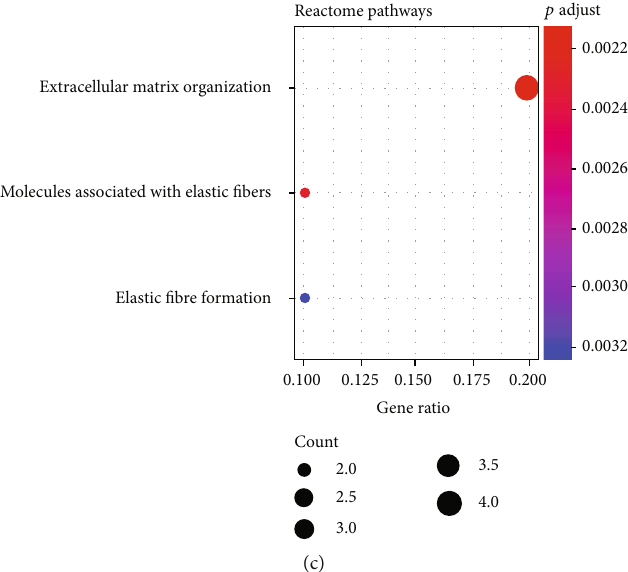
Figure 2: Signi fi cantly enriched GO terms and pathway terms. (a) Top 30 signi fi cantly enriched GO terms related to the biological process. (b) 2 GO terms related to the cellular component were signi fi cantly enriched. (c) 3 REACTOME pathways were signi fi cantly enriched. No GO terms related to the molecular function or KEGG pathway were signi fi cantly enriched. The gene ratio is the proportions of di ff erentially expressed mRNAs that were correlated with a certain term. The count of mRNAs related to each term was shown by the dot size. The signi fi cance was shown by the dot color. Red indicates greater signi fi cance; blue indicates less signi fi